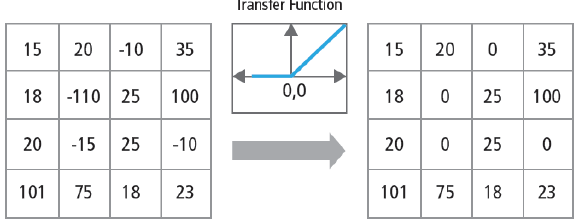
Fig. 4. Pictorial representation of ReLU